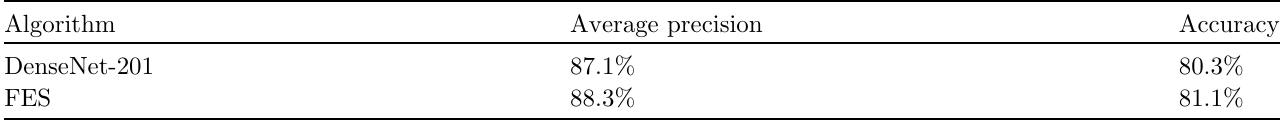
Table 7. Method generality experiment results. Average precision and accuracy are reported with 68% con fi dence